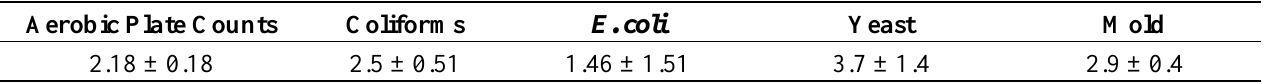
Table 2. Logarithmic reductions following an acetic acid intervention at various concentrations and contact times against spoilage and fecal microorganisms present on lettuce (APC, coliforms, E.coli , yeast and